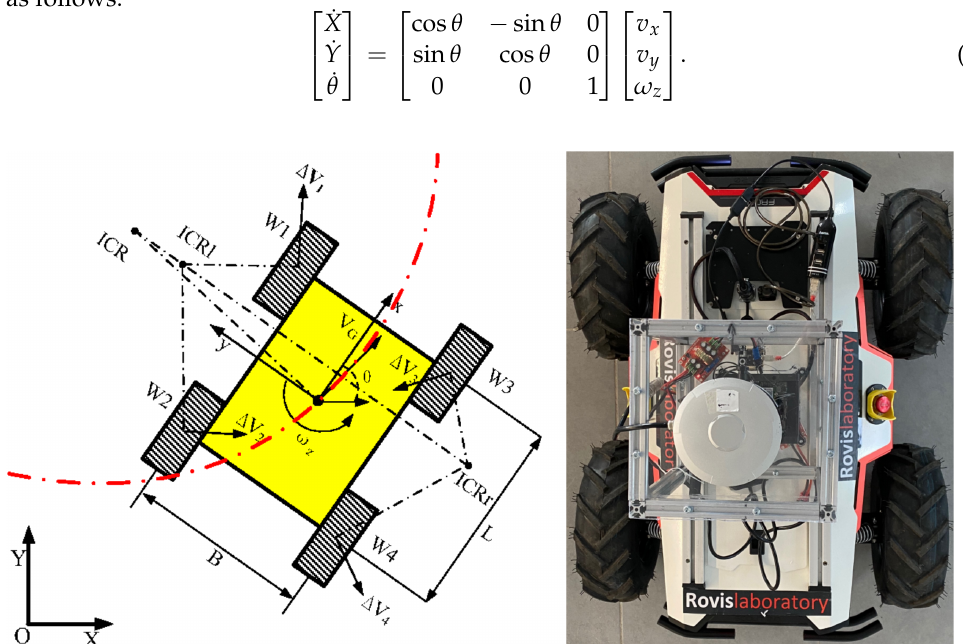
Figure 4. A skid-steering mobile robot’s kinematics diagram and the top view of RovisLab Au- tonomous Mobile Test